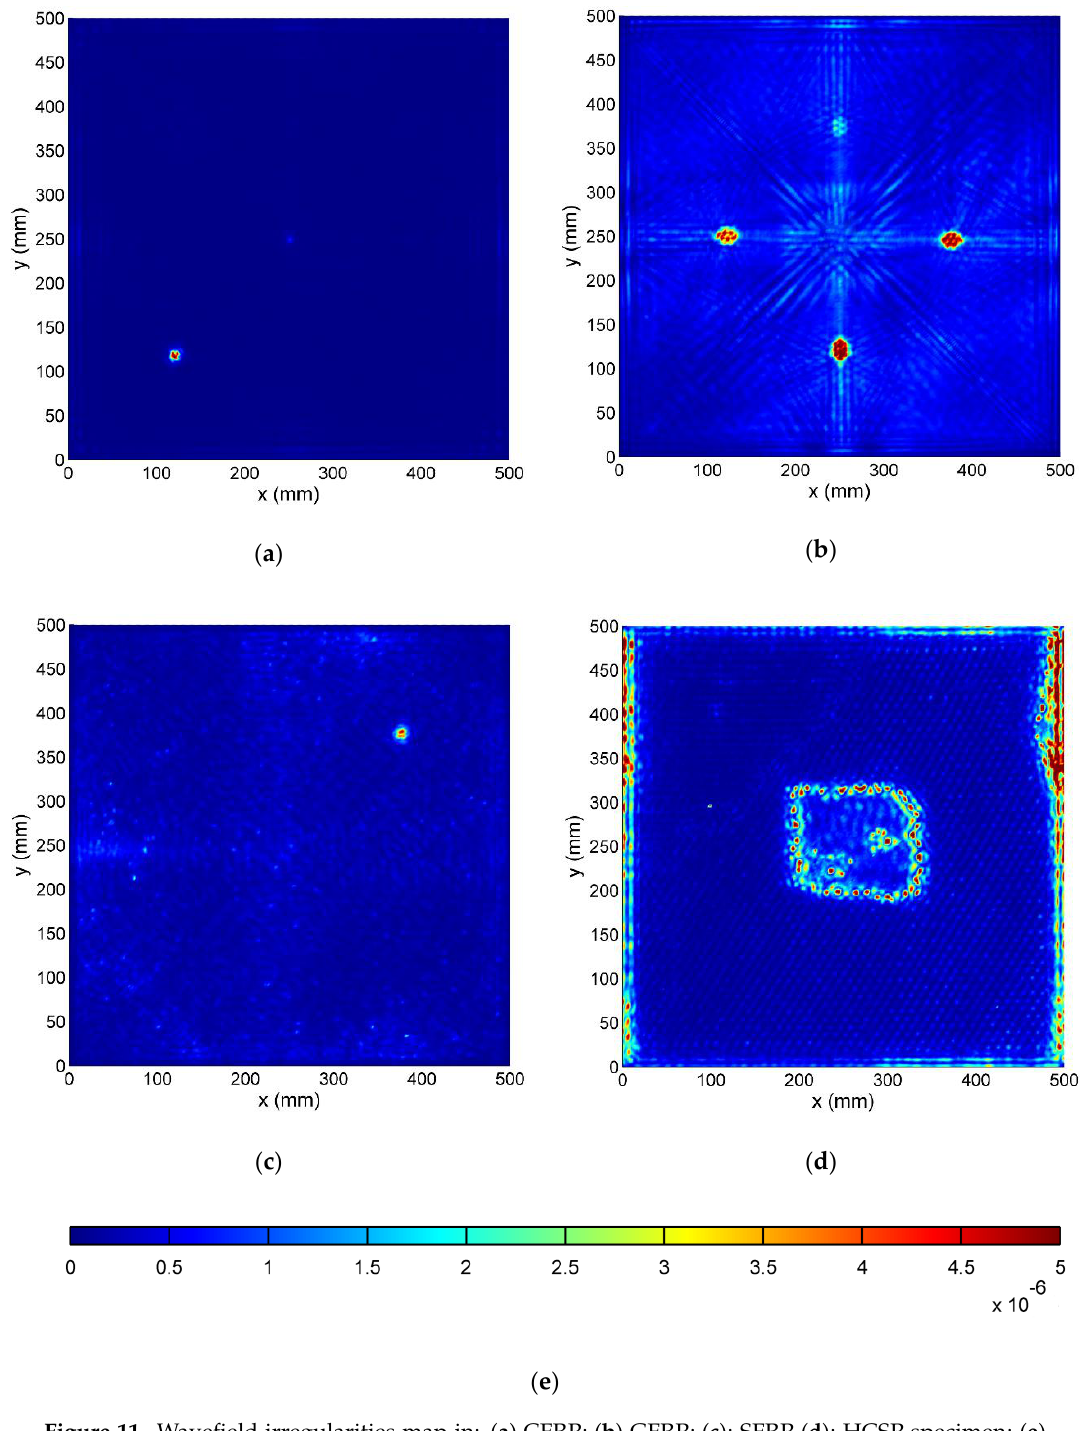
Figure 11. Wavefield irregularities map in: ( a ) CFRP; ( b ) GFRP; ( c ); SFRP ( d ); HCSP specimen; ( e ) Color scale.